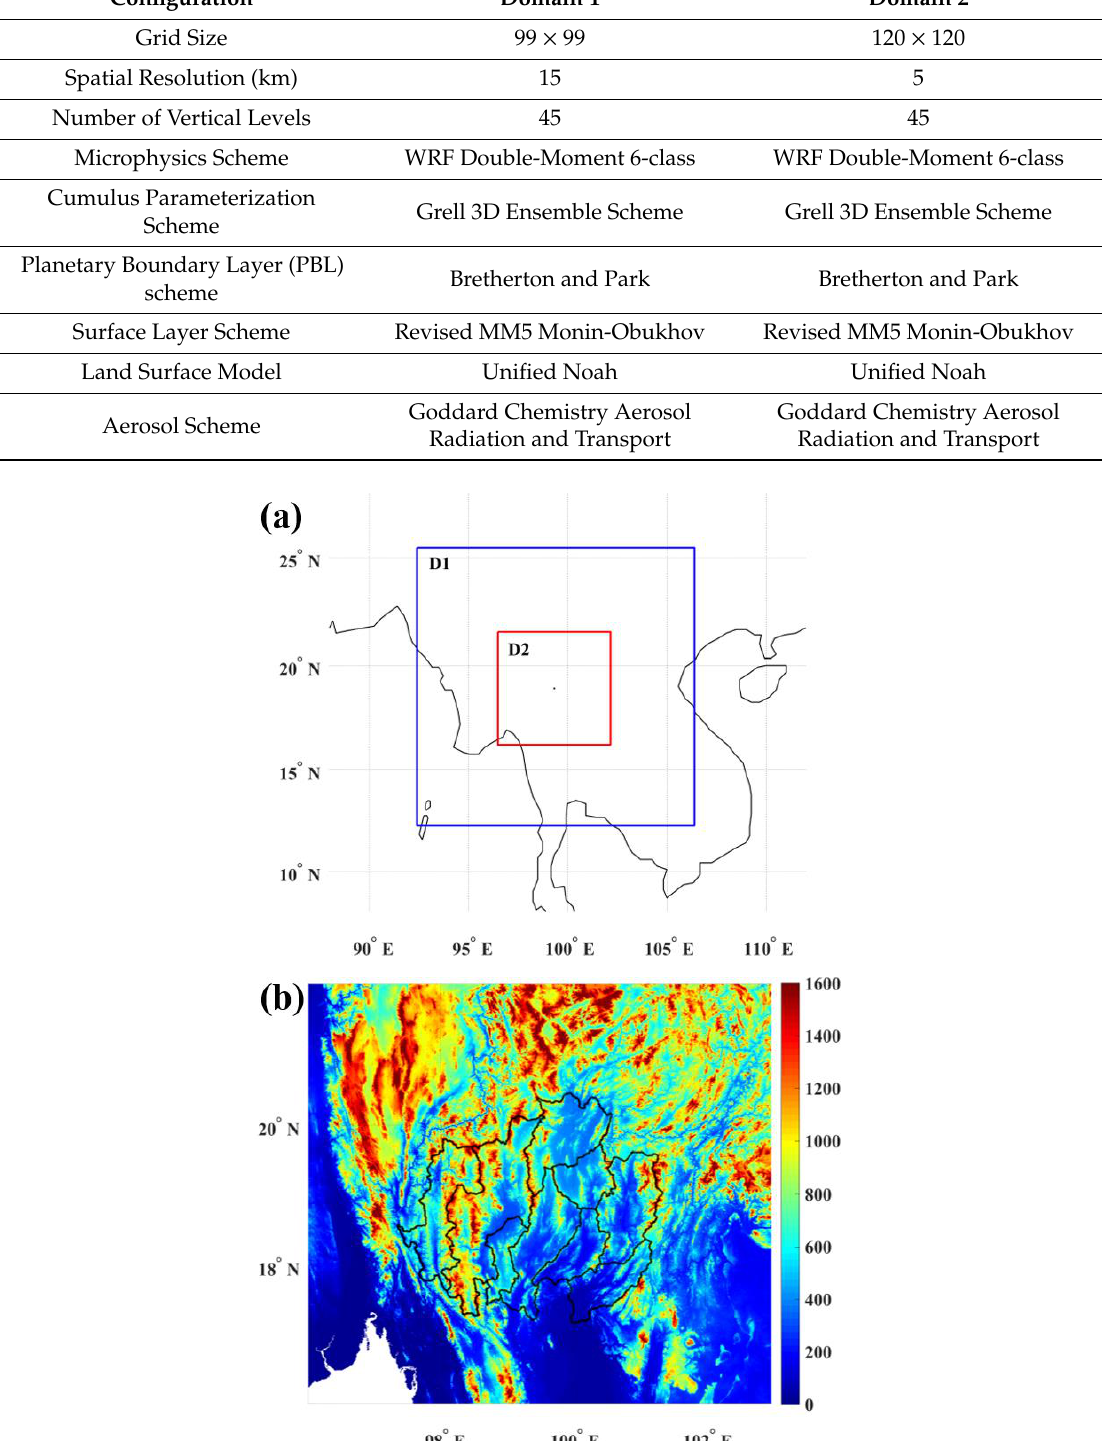
Figure 4. ( a ) Coverages of two nested WRF domains employed in this study. ( b ) Topography (m) above mean sea level of WRF domain 2.